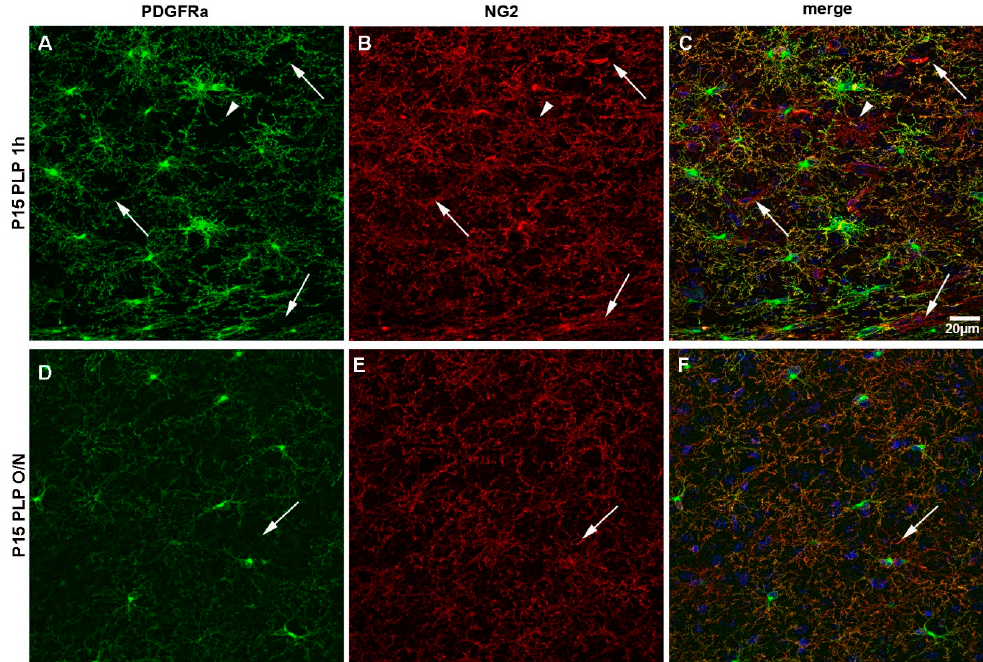
Figure 10. NG2 versus PDGFR α staining of OPCs. Comparison between NG2 and PDGFR α staining for the P15 PLP 1 h and the P15 PLP O/N groups. ( A – C ): Staining for PDGFR α (green) is more pronounced on the cell soma, but protrusions are clearly visible. Staining for NG2 (red) is less bright on the soma but more pronounced on protrusions. There are more protrusions visible with staining for NG2. Blood vessels are stained by NG2 but not by PDGFR α (pericytes, arrows). There are rare cells that are stained positively for NG2 but not PDGFR α (arrowhead). DAPI staining is shown in blue. ( D – F ): Overnight post-fixation with PLP decreases both PDGFR α and NG2 staining. PDGFR α , especially on distal protrusions, seems to be more vulnerable to long fixation compared to NG2. Scale bar represents 20 µm.